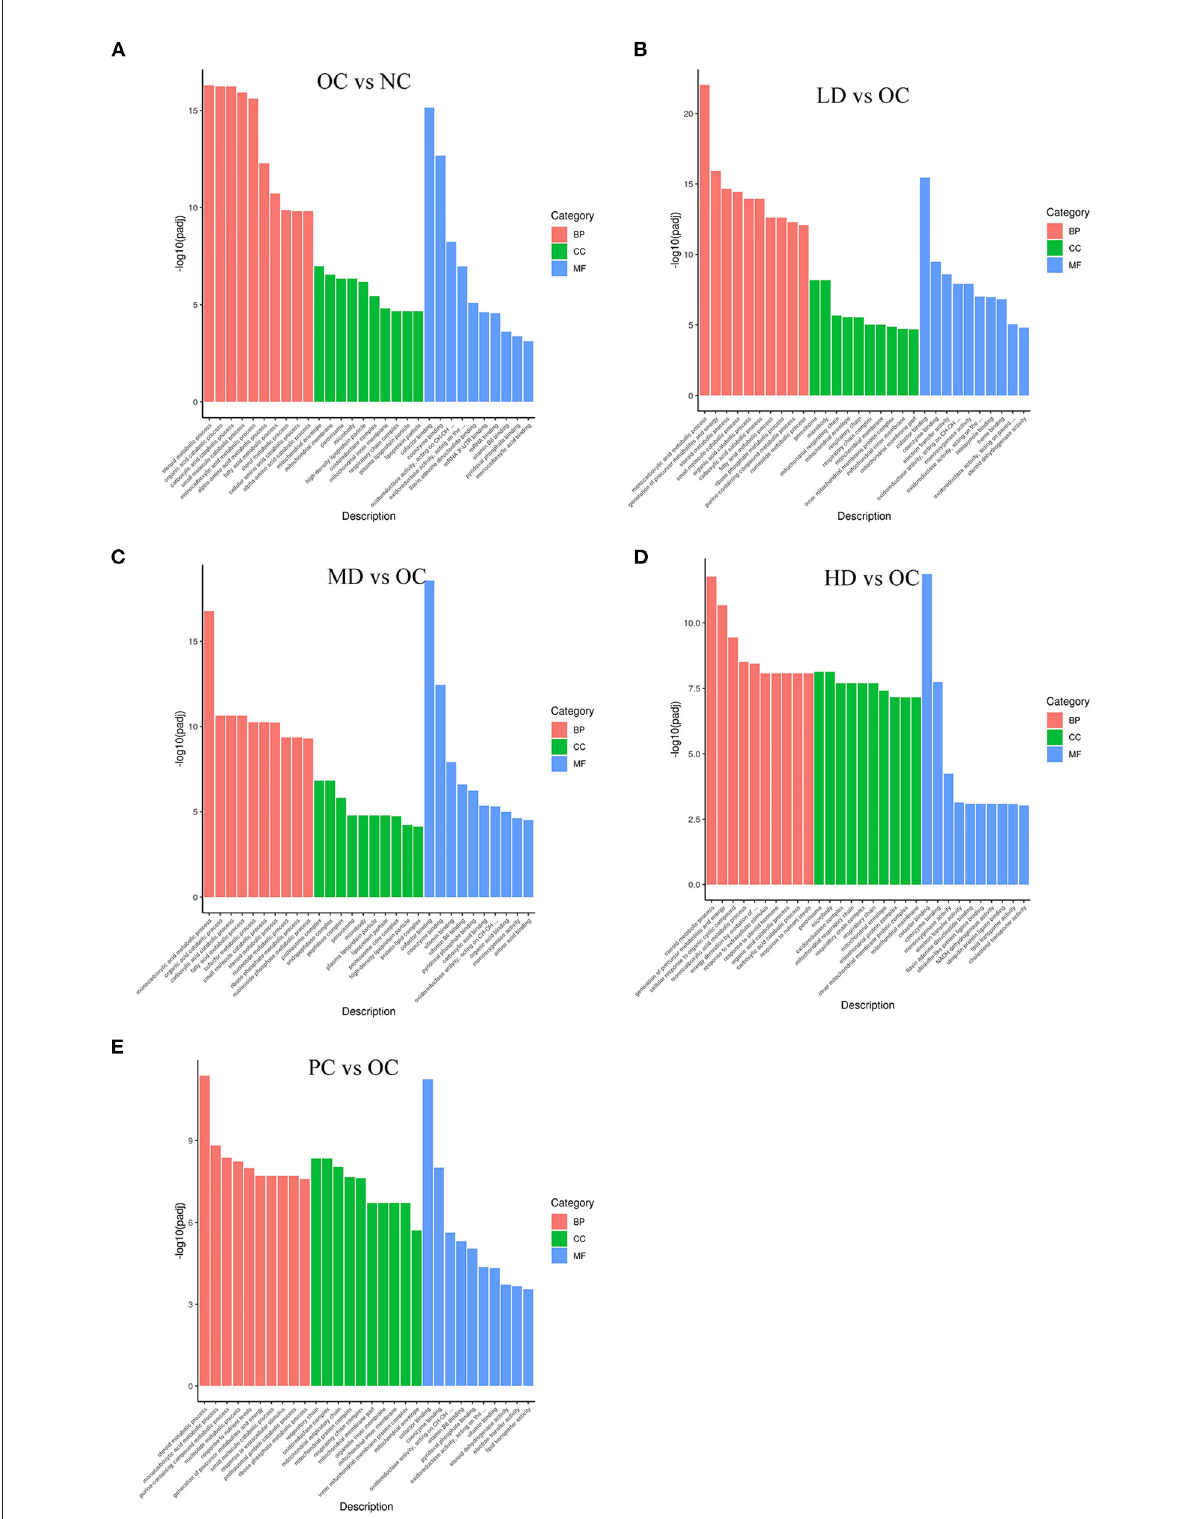
FIGURE5 GO enrichment of differential genes (A) OC vs. NC (B) LD vs. OC (C) MD vs. OC (D) HD vs. OC (E) PC vs. OC. The abscissa is GO Term, and the ordinate is the significance level of GO Term enrichment, which is represented by –log10(padj), different colors represent different functional